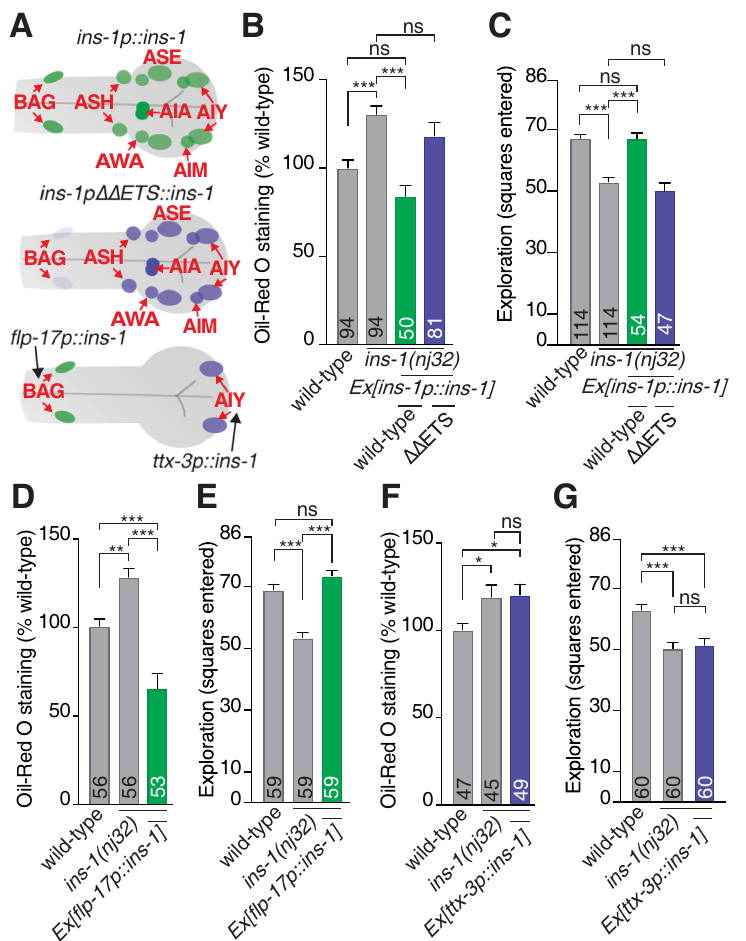
Fig 5. INS-1 regulates intestinal fat levels specifically from the BAG neurons. (A) Schematic of expression pattern observed for wild-type ins-1 promoter (upper panel) and ins-1 promoter with both ETS site mutated (middle panel), the BAG-specific flp-17 promoter (green neurons, lower panel), and AIY-specific ttx-3 promoter (blue neurons, lower panel). (B) ORO quantification of ins-1(nj32) rescued with wild-type Ex[ins-1p :: ins-1cDNA] (green bar), or mutant Ex [ins-1 ΔΔ ETSp :: ins-1cDNA ](blue bar), compared to ins-1(nj32) and wild-type. (C) Exploration assay of ins-1(nj32) rescued with wild-type Ex[ins-1p :: ins-1cDNA] (green bar), or mutant Ex[ins-1 ΔΔ ETSp :: ins-1cDNA ] (blue bar), compared to ins-1(nj32) and wild-type. (D) Quantification of ORO staining of ins-1(nj32) ; Ex[flp-17p :: ins-1cDNA] (BAG-specific, green bar) compared to ins-1(nj32) and wild-type. (E) Exploration assay of ins-1(nj32) ; Ex[flp-17p :: ins- 1cDNA] (BAG-specific, green bar) compared to ins-1(nj32) and wild-type. (F) Quantification of ORO staining of